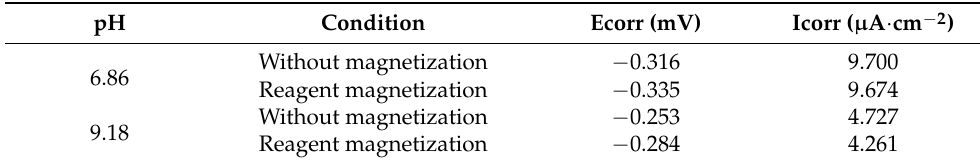
Figure 12. The effect of magnetization on the polarization curve of chalcopyrite at pH = 6.86 ( a ) and pH = 9.18 ( b ). Table 2. Electrolytic corrosion parameters of chalcopyrite surface in different pH